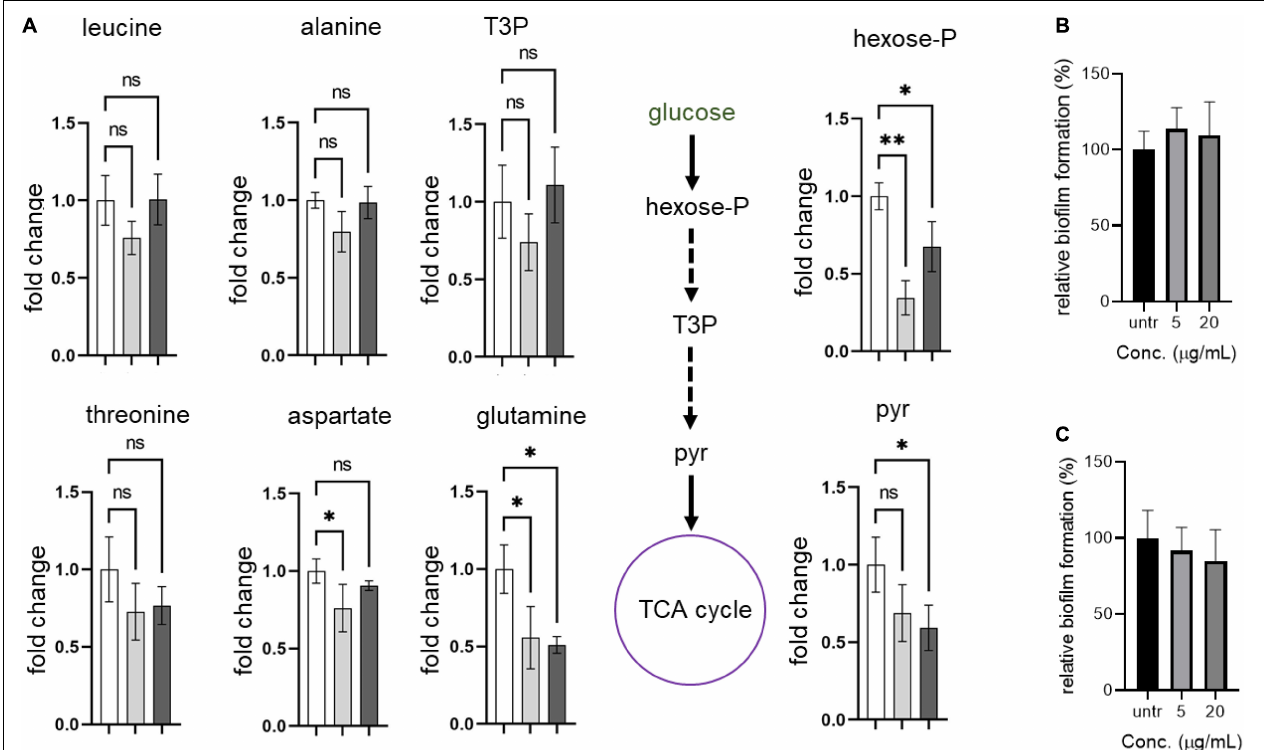
FIGURE 5 | Compounds lead to metabolic remodeling in USA 300. (A) USA300 were treated with 5 µ g/mL of compound 2 or 4 for 1 h. Fold change is expressed relative to the untreated culture with three biological replicates ( n = 3) ± standard deviation. Statistically significant differences were defined as ∗ P ≤ 0.05 and ∗∗ P ≤ 0.01. Open bar represents untreated group, while gray and black bars represent groups treated with compounds 2 and 4 , respectively. (B,C) Glutamine antagonizes the anti-biofilm activity of compounds 2 and 4 . Quantification of relative biofilm formation of S. aureus USA300 was performed in the presence of 1 mg/mL glutamine and compound 2 (B) or 4 (C) .Hexose-P, glucose-6-phosphate and its isomers; T3P, triose 3-phosphates (dihydroxyacetone phosphate and glyceraldehyde phosphate); pyr, pyruvate.